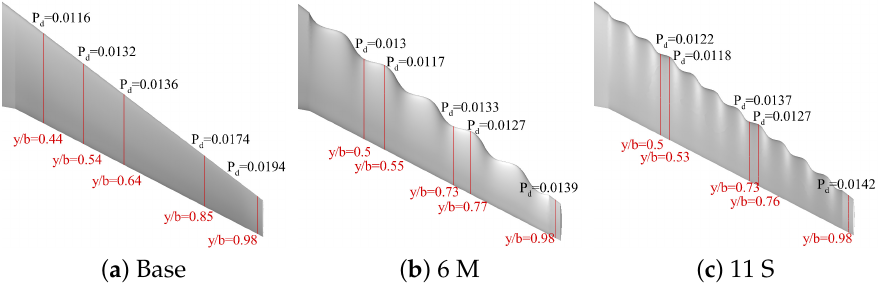
Figure 14. Procrustes distance at different cross